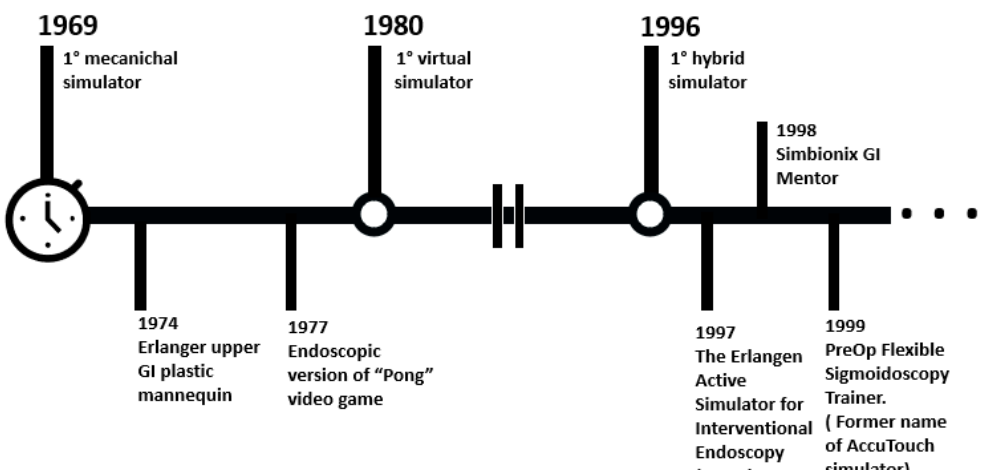
Figure 2. First steps of GI endoscopy simulators.